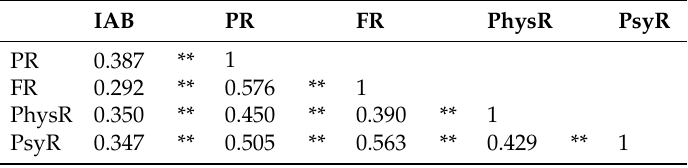
Table 3. Bivariate correlations of the perceived risk dimensions ( n =